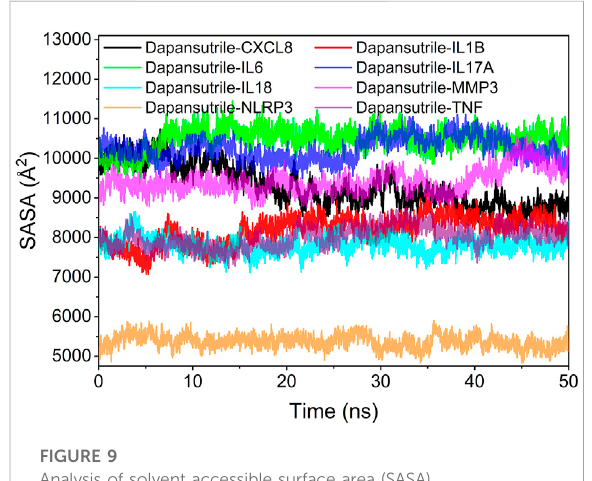
FIGURE 9 Analysis of solvent accessible surface area